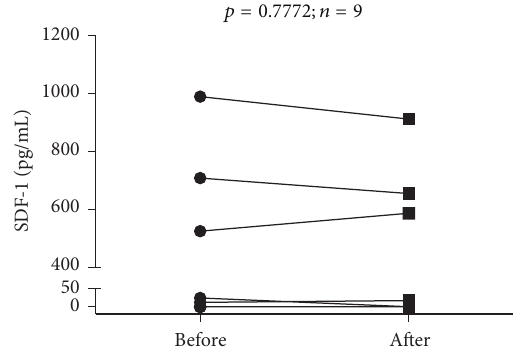
Figure 5: Time-course analysis of individual changes in serum levels of SDF-1 in the course of FSH